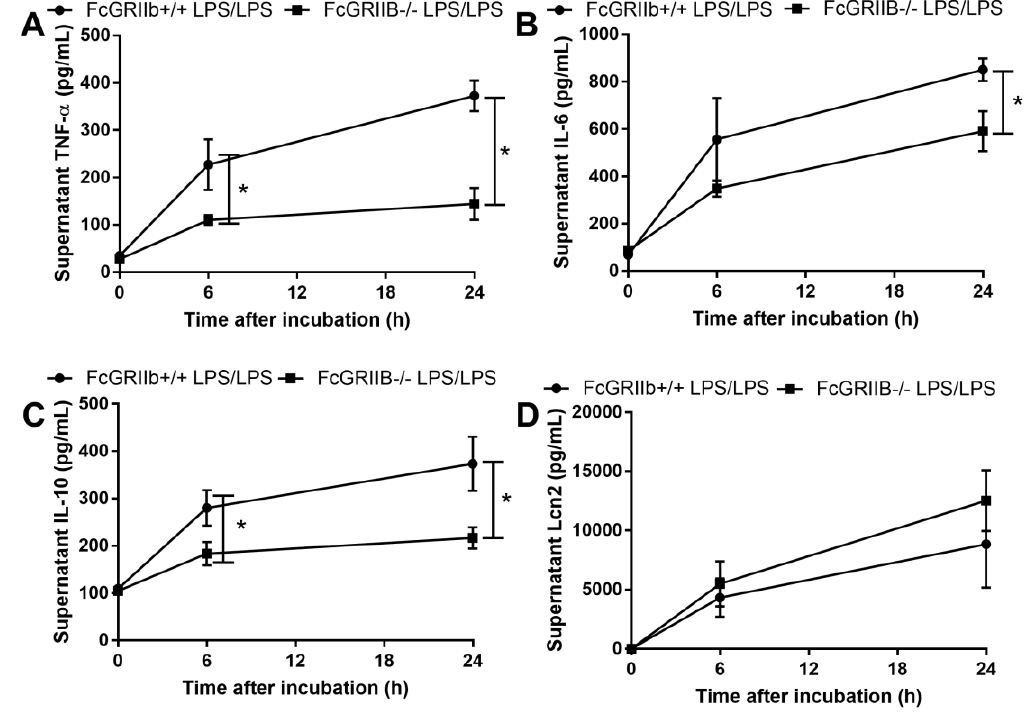
Figure 6. The characteristics of bone marrow derived macrophage from wild-type (FcGRIIb +/+ ) and FcGRIIb- / - mice with double LPS stimulation (LPS / LPS; LPS tolerance) as determined by supernatant cytokines ( A – C ) and Lipocalin-2 (Lcn-2) ( D ) were demonstrated. (Independent triplicate experiments were performed for all experiments; *, p < 0.05).